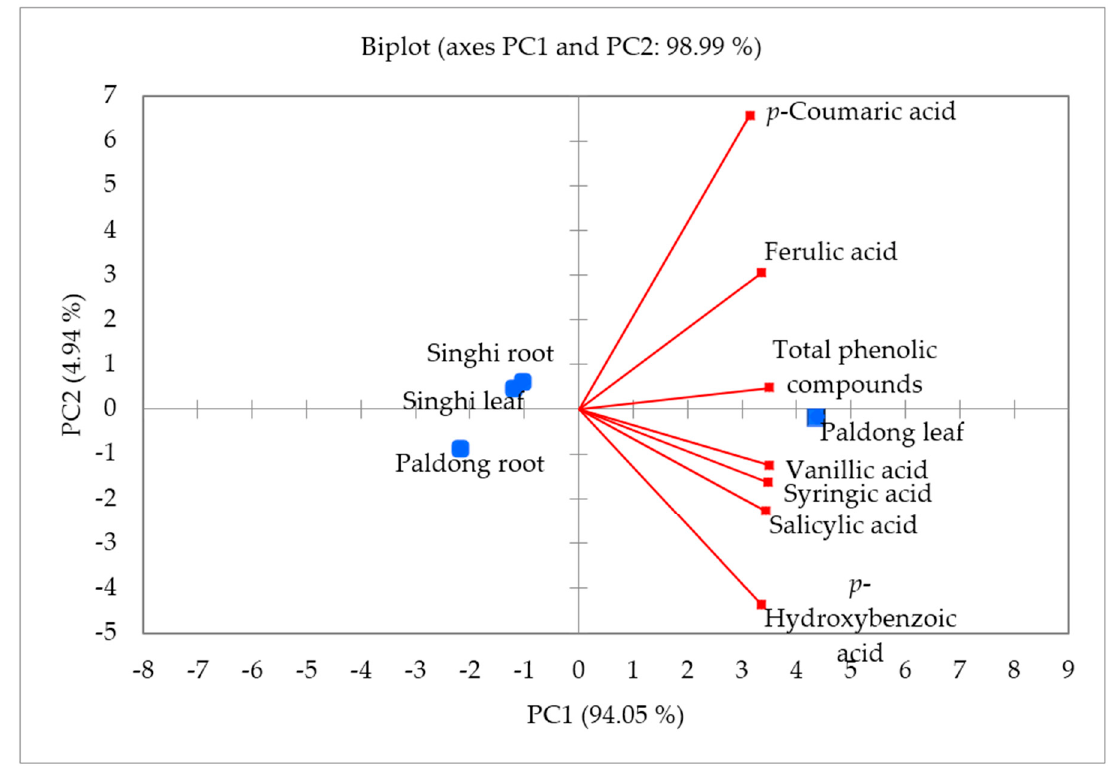
Figure 4. Principal component analysis (PCA) biplot constructed variance, based on the phenolic compounds identified from Paldong cultivars.